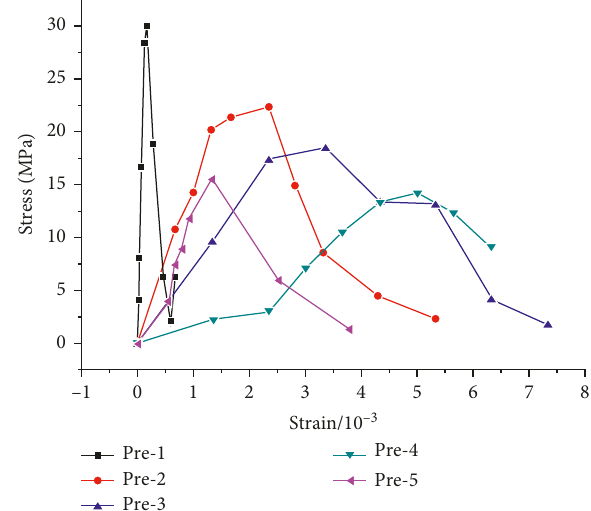
Figure 6: The stress of a certain unit and the strain